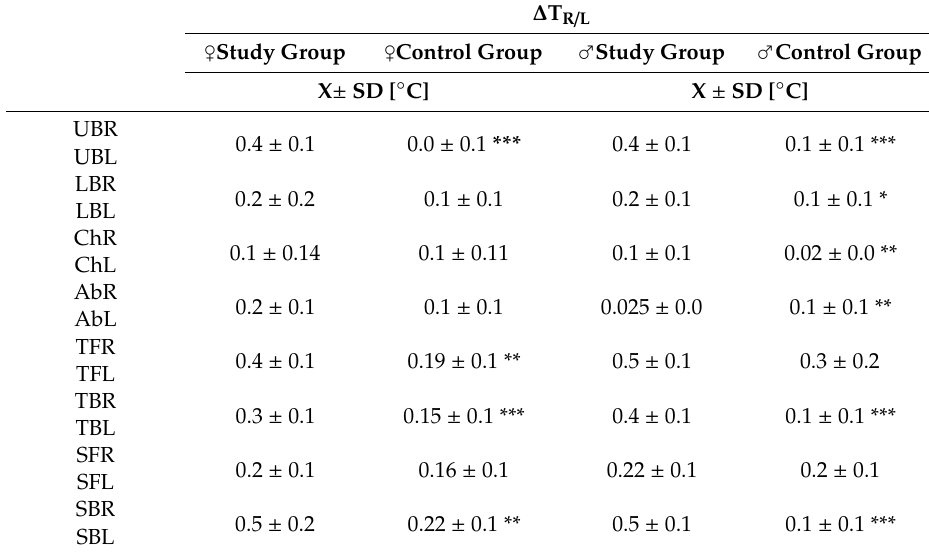
Table 5. Di ff erences in the values of mean temperature of selected areas between the right and left side of the body ( ∆ T R / L ) listed separately for girls and boys in both groups.